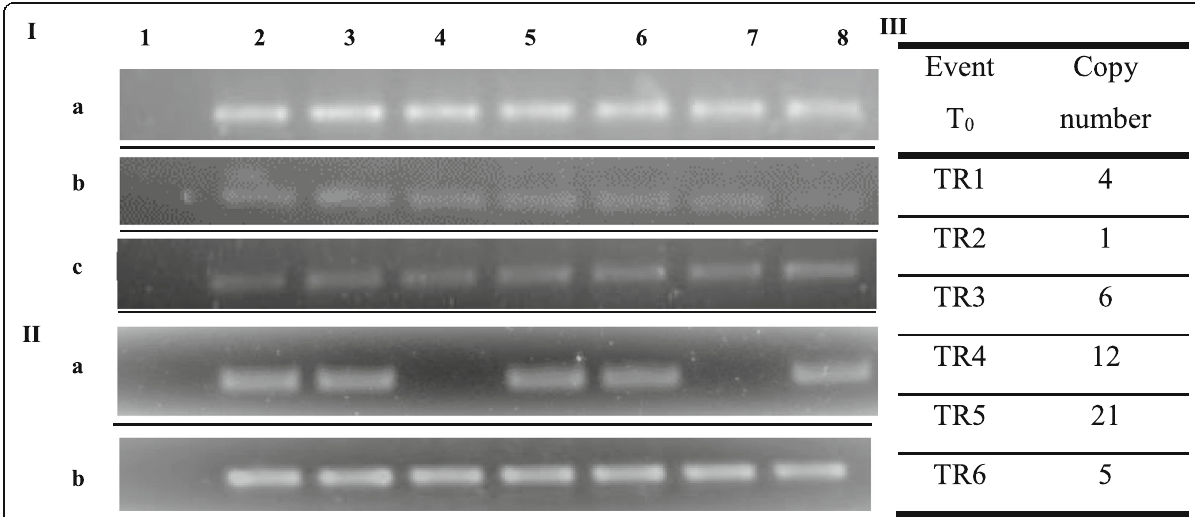
Fig. 2 Molecular analysis of transgenic wheat plants. I Analysis by PCR of the IPT gene (a), BAR gene (b), and GHS gene (c). Lane 1, negative control; lane 2, positive control; lanes 3 – 8, six independent putative transgenic plants; all plants had the amplified gene as expected. II Analysis by RT-PCR of the BAR gene (a) and GHS gene (b). Lane 1, negative control; lane 2, positive control; lanes 3 – 8, six independent putative transgenic plants. III Southern blot analysis on T 1 plants derived from transgenic events, indicating the number of copies of each transgenic event